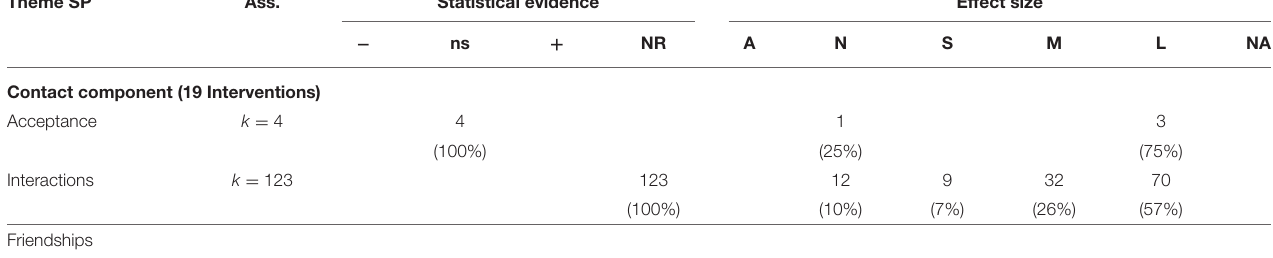
TABLE 8B | Number of associations by intervention component and by social participation theme from single/multiple case design studies. Theme SP